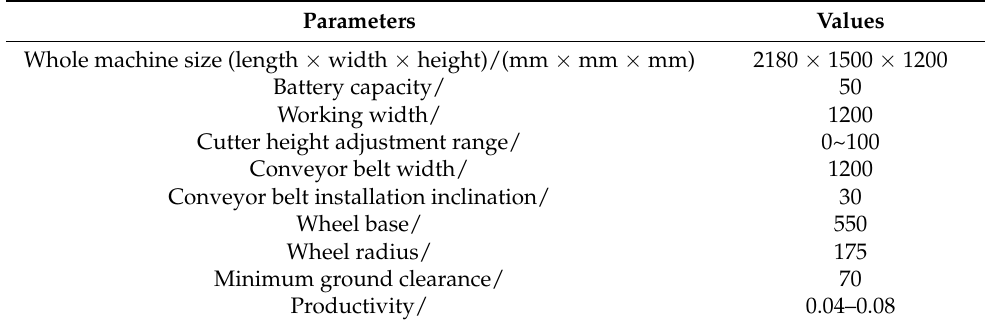
Figure 1. Sketch of the structure of the 4UM-120D electric leafy vegetable harvester. 1. Reciprocating double-action cutter; 2. Paddle mechanism; 3. Slide rail; 4. Electric pusher; 5. Conveying mechanism; 6. Control box; 7. 48 V lithium battery; 8. Differential mechanism; 9. Reducer; 10. Travel drive motor; 11. Collection basket; 12. Control panel; 13. Gear switching handle; 14. Brake handle; 15. Wheel. Table 1. The 4UM-120D electric leafy vegetable harvester’s structural and technical parameters. Parameters